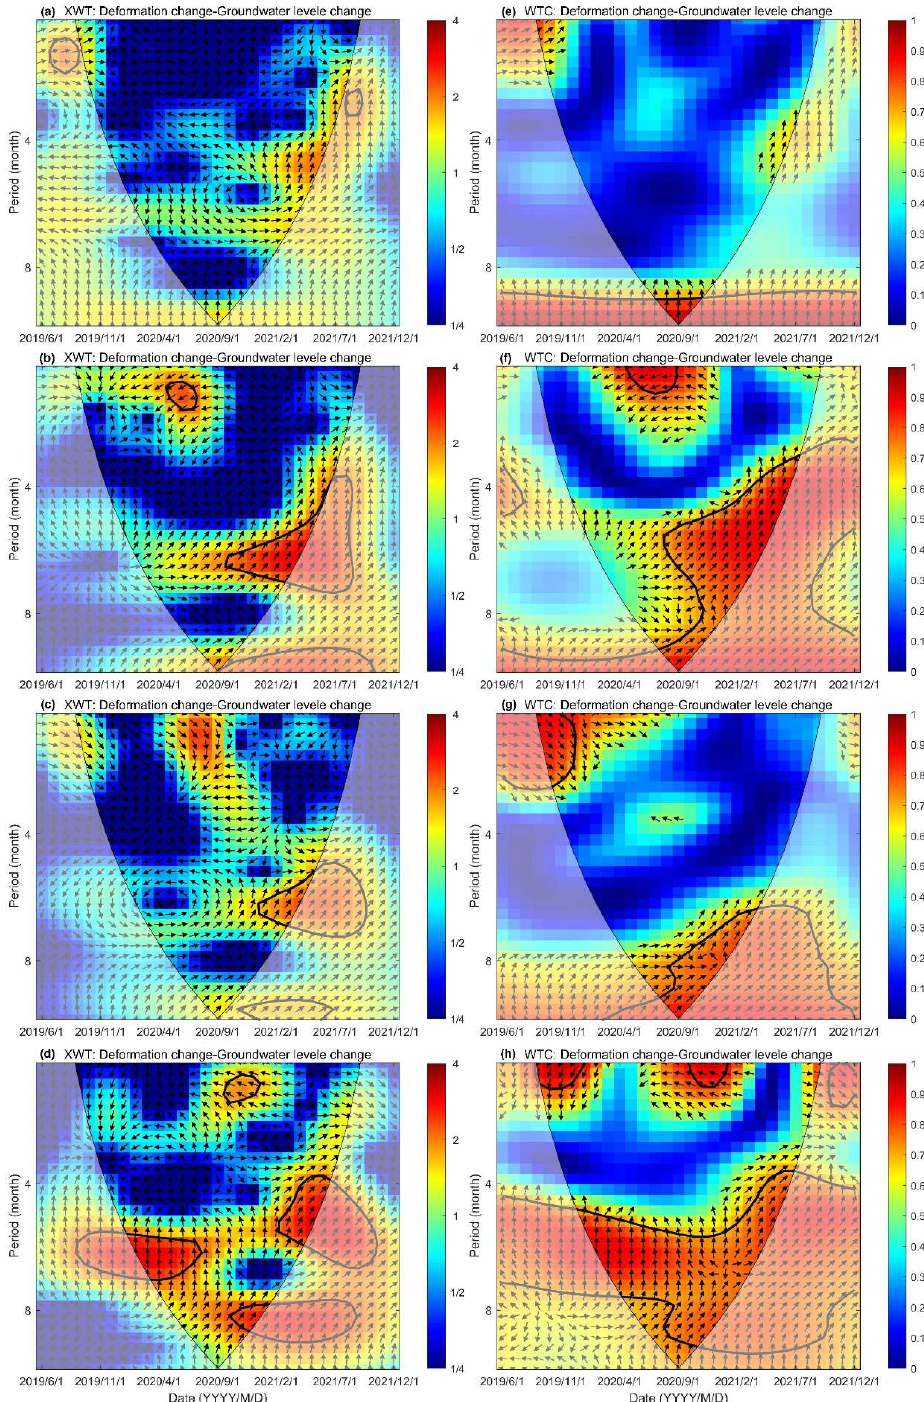
Figure 12. The cross wavelet power spectrum and the wavelet coherence between groundwater level change and InSAR-derived deformation change at four selected regions (A1: ( a , e ); A2: ( b , f ); A3: ( c , g ); A4: ( d , h )). Pointing-right arrows: in-phase correlations, Pointing-left arrows: anti-phase correlations; Straight-down arrows: groundwater level change preceding InSAR-derived deformation change by 90°. The color bar of XWT and WTC shows the common cross-wavelet power of groundwater level change and InSAR‑derived deformation change. The blue represents the low power while red represents the high